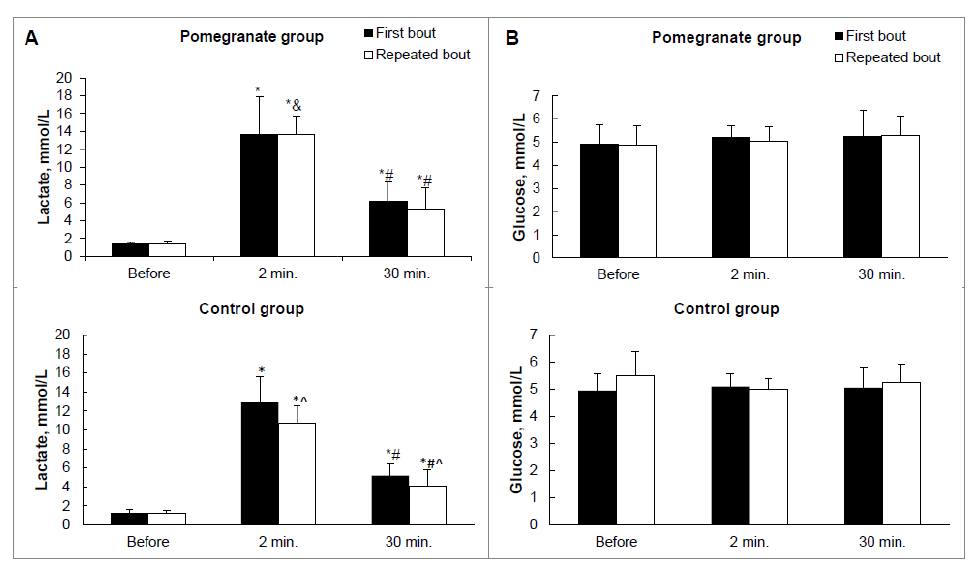
Figure 3. Lactate and glucose concentrations in pomegranate and control groups. ( A ) Lactate; ( B ) Glucose. * p < 0.05 compared with baseline values; # p < 0.05 between 2 min and 30 min; & p < 0.05 compared with control values; ^ p < 0.05 between first bout and repeated bout.